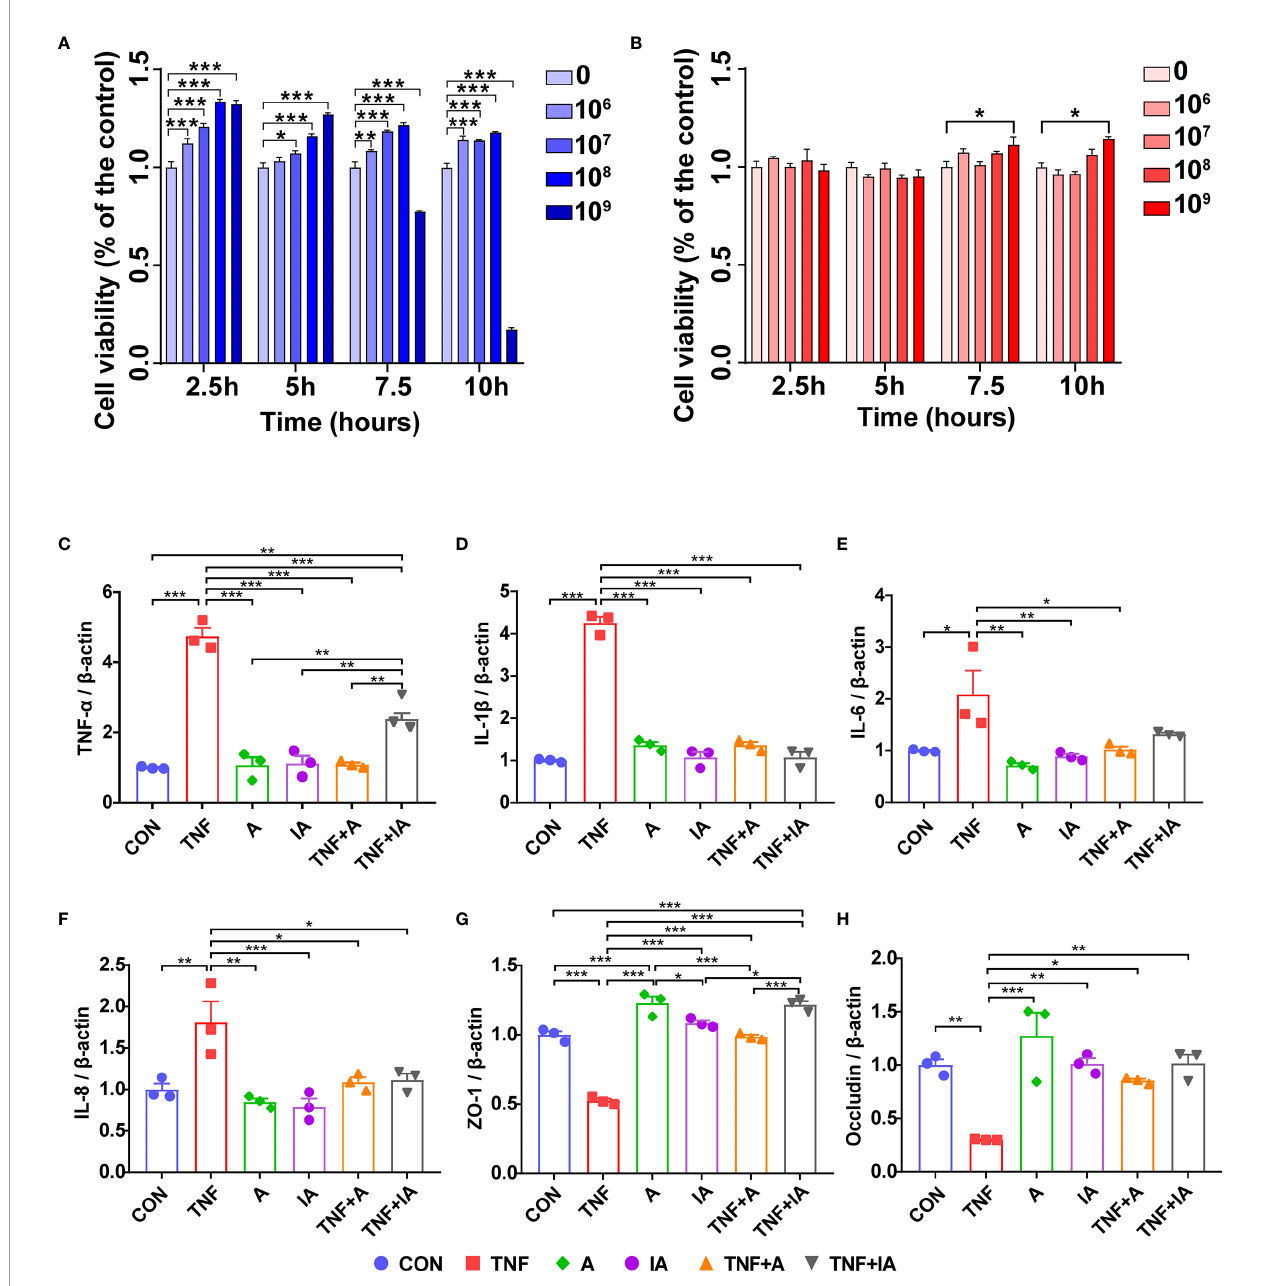
FIGURE 4 | The cell viability of IPEC-J2 cells treated with active or inactive A. muciniphila . and mRNA level of in fl ammation related cytokines and tight junctions of the IPEC-J2 cells in different groups. (A) The viability of IPEC-J2 cells co-cultured with living (active) A. muciniphila at 0, 10 6 , 10 7 , 10 8 and 10 9 copies/mL for 2.5, 5, 7.5 and 10 h, respectively. (B) The viability of IPEC-J2cells co-cultured with inactive (autoclaved) A. muciniphila at 0, 10 6 , 10 7 , 10 8 and 10 9 copies/mL for 2.5, 5, 7.5 and 10 h, respectively. (C) The mRNA level of TNF- a of IPEC-J2 cells in different groups. (D) The mRNA level of IL-1 b of IPEC- J2 cells in different groups. (E) The mRNA level of IL-6 of cells in different groups. (F) The mRNA level of IL-8 of IPEC-J2 cells in different groups. (G) The mRNA level of Occludin of IPEC-J2 cells in different groups. (H) The mRNA level of Occludin of IPEC-J2 cells in different groups. CON, cells treated with PBS for 48 h. TNF, cells challenged with 20 ng/mL Recombinant Susscrofa TNF- a for 48 hours. A, cells co-cultured with 10 8 copies/mL active A. muciniphila for 48 h. IA, cells co-cultured with10 9 copies/mL inactive A. muciniphila for 48 h. TNF+A, cells challenged with 20 ng/mL TNF- a for 40.5 h and then co-cultured with 10 8 copies/mL active A. muciniphila for 7.5 h. TNF+IA, cells challenged with 20 ng/mL TNF- a for 40.5 h and then co-cultured with 10 9 copies/mL inactive A. muciniphila for 7.5 h. * P < 0.05, ** P < 0.01, *** P < 0.001. Data are expressed as mean ± SEM (n = 3). Results represented one of the three independent